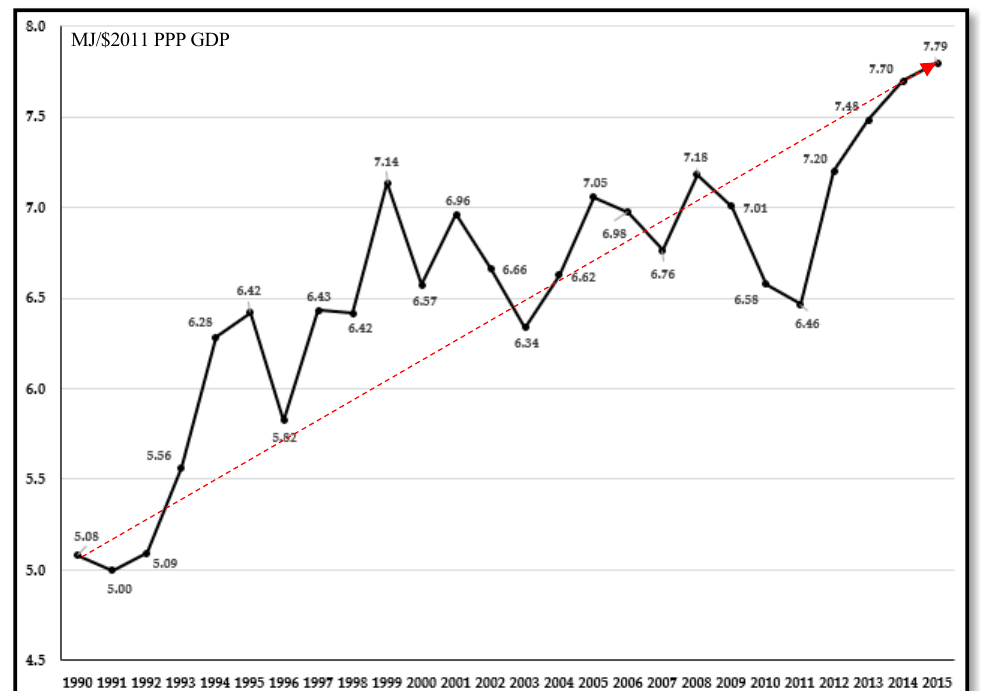
Figure 9. Energy intensity level of primary energy [35].